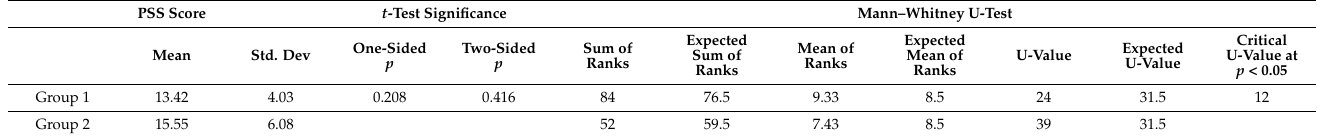
of the two groups. The differences did not prove to be statistically important in either